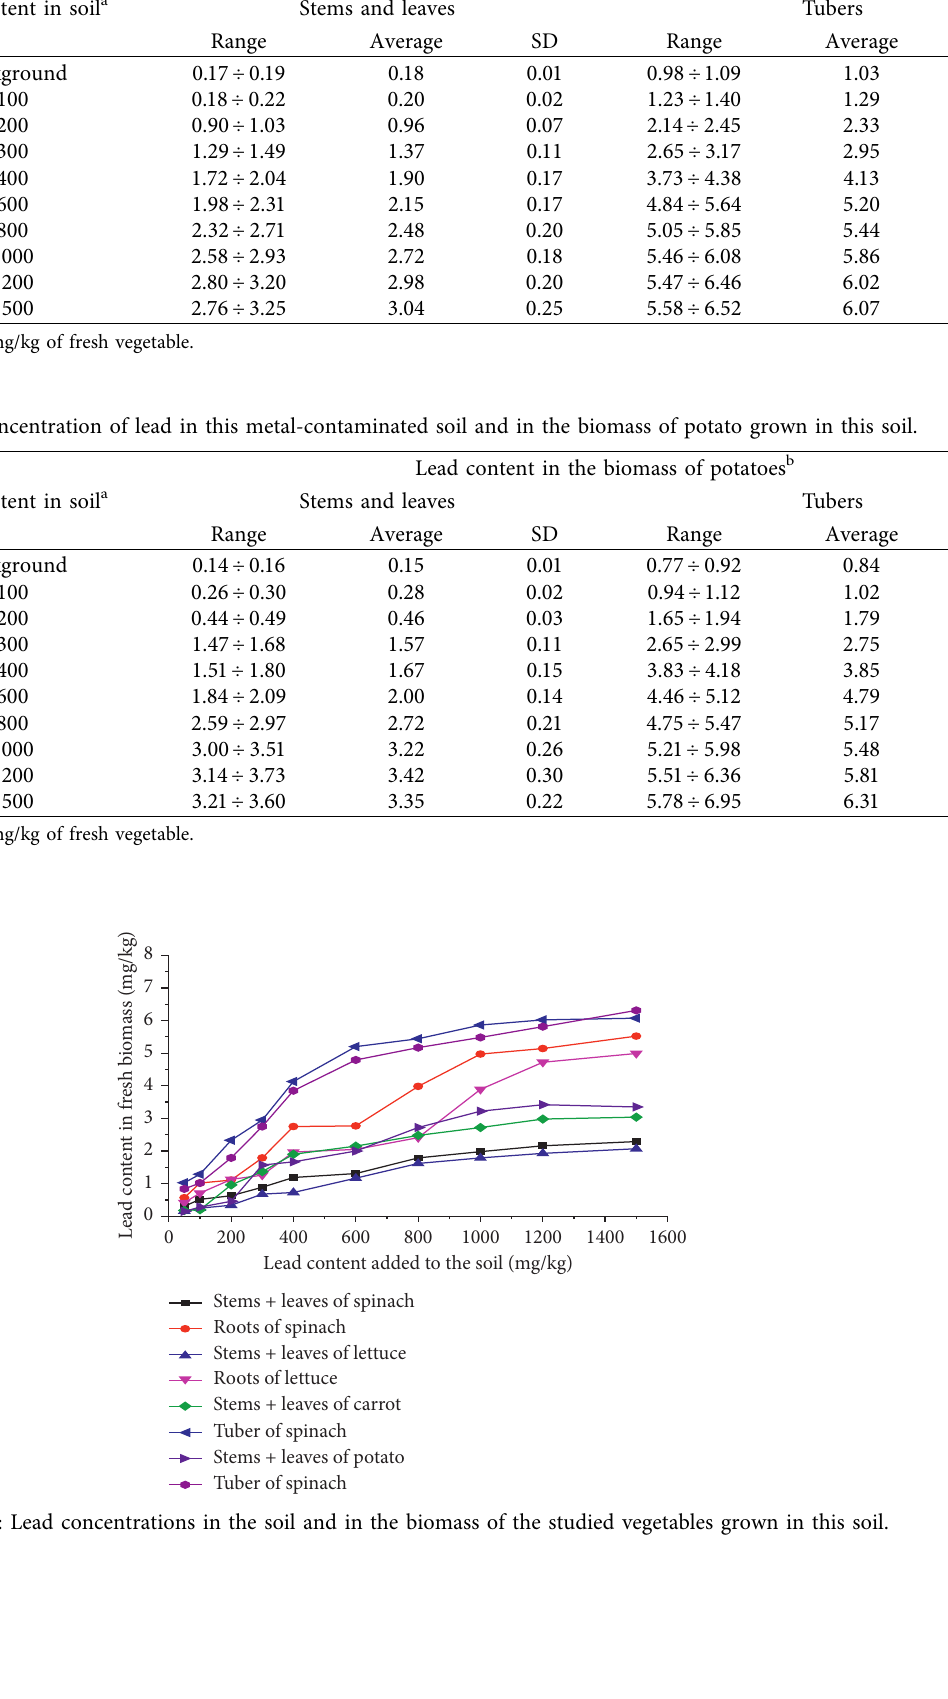
Table 5: Concentration of lead in this metal-contaminated soil and in the biomass of carrot grown in this soil. Lead content in the biomass of carrots b Entry Lead content in soil a